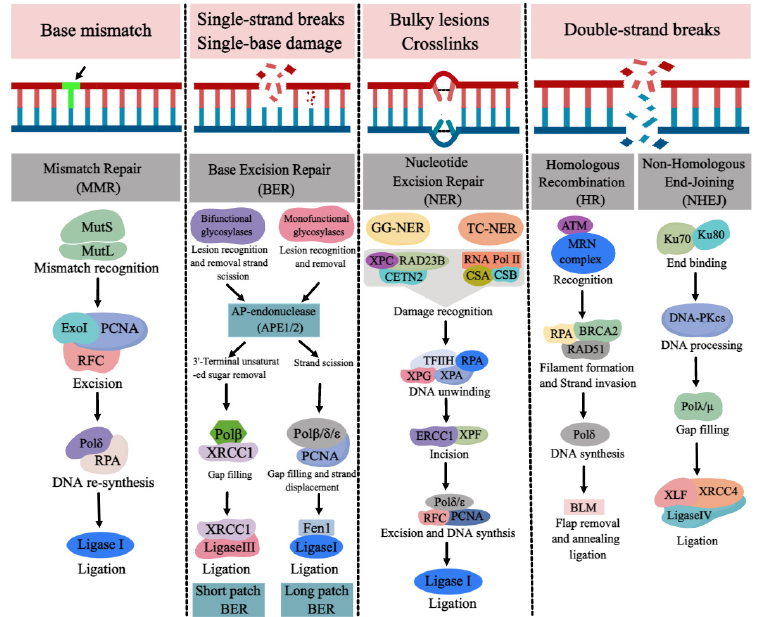
Figure 4. The major types of DNA repair pathways. Base mismatch is repaired by mismatch repair (MMR), single-strand breaks (SSBs) and single-base damage is repaired by base excision repair (BER). Bulky lesions and crosslinks are repaired by nucleotide excision repair (NER) and double-strand breaks (DSBs) are repaired by homologous recombination (HR) and nonhomologous end joining (NHEJ). (Created with https://image.medpeer.cn, accessed on 30 November 2022).